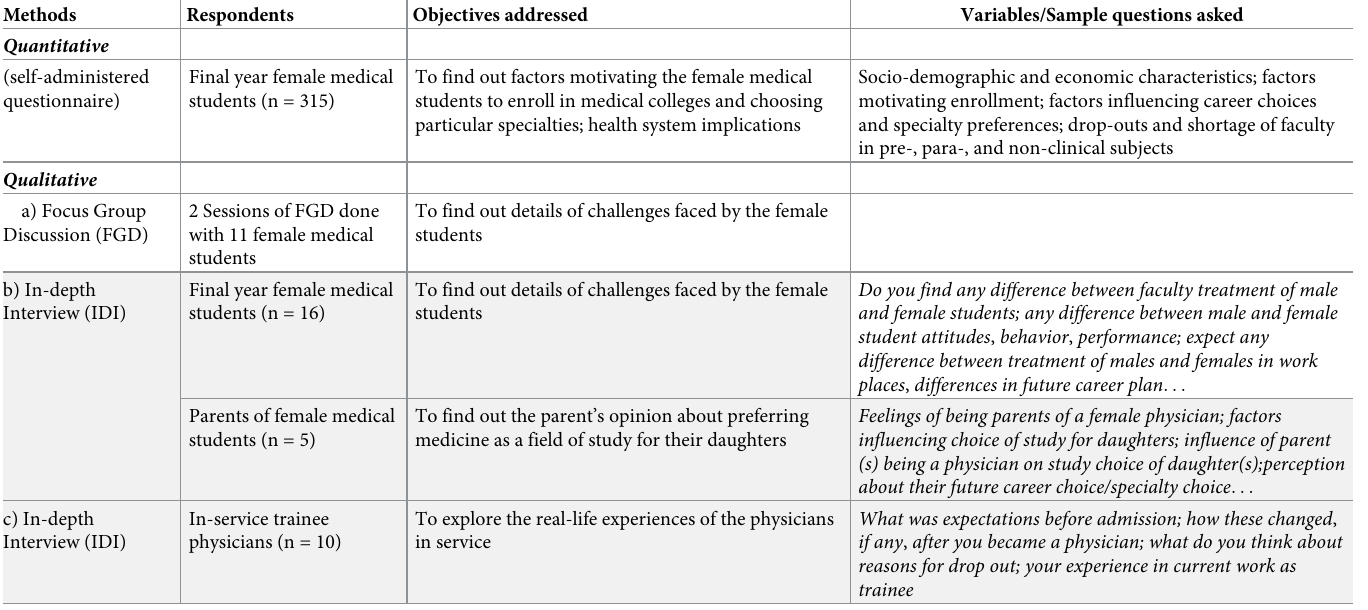
Table 1. Summary of the methods, respondents, objectives addressed and some variables/sample